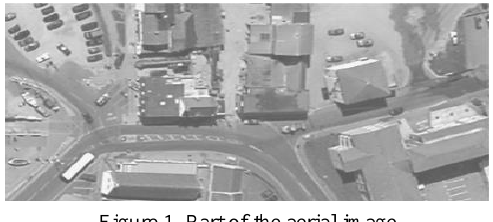
Figure 1. Part of the aerial image